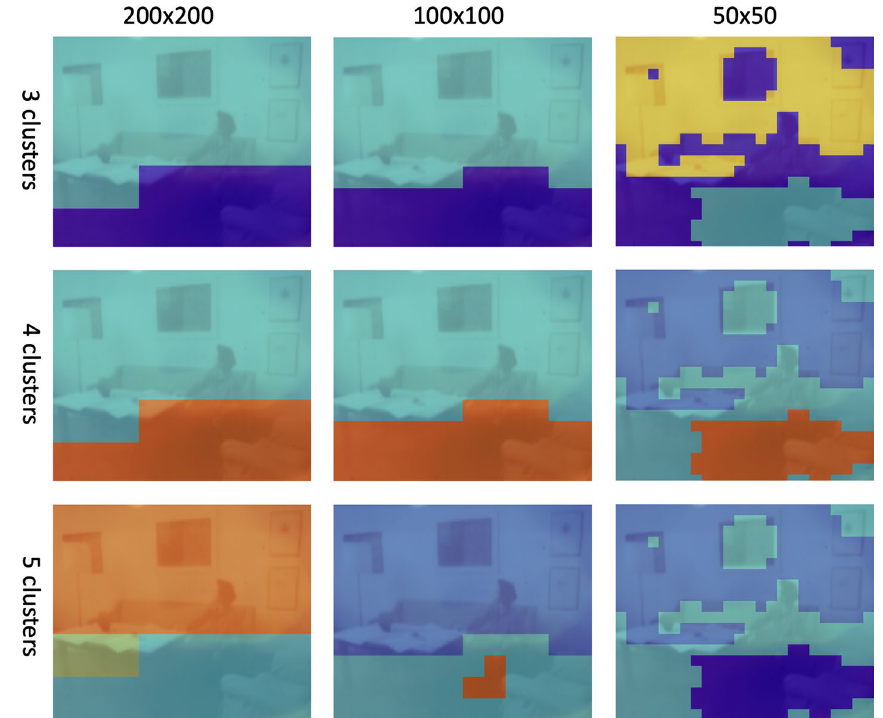
Fig. 5 Comparison of segmentation results obtained with different grid sizes, employing the Euclidean distance and the weighted agglomeration